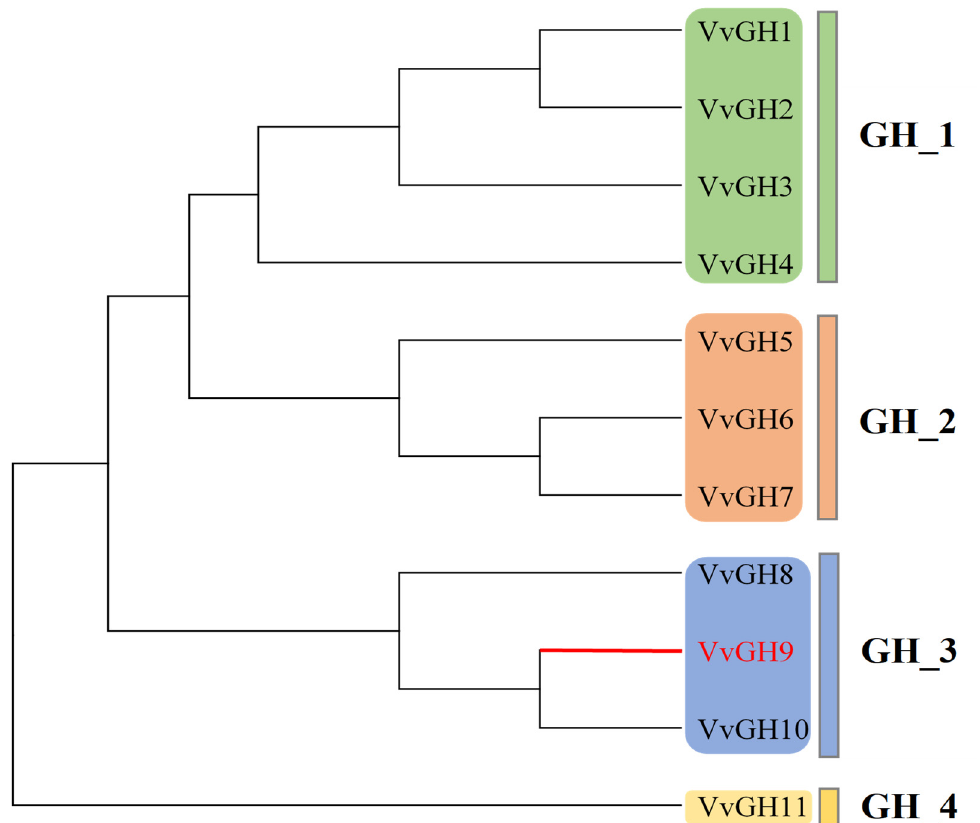
Figure 1. Phylogenetic analysis of GH genes in V. vinifera . The unrooted tree was generated by ClustalW in MEGA7 using the conserved amino acid sequences of the 11 V. vinifera GH proteins.